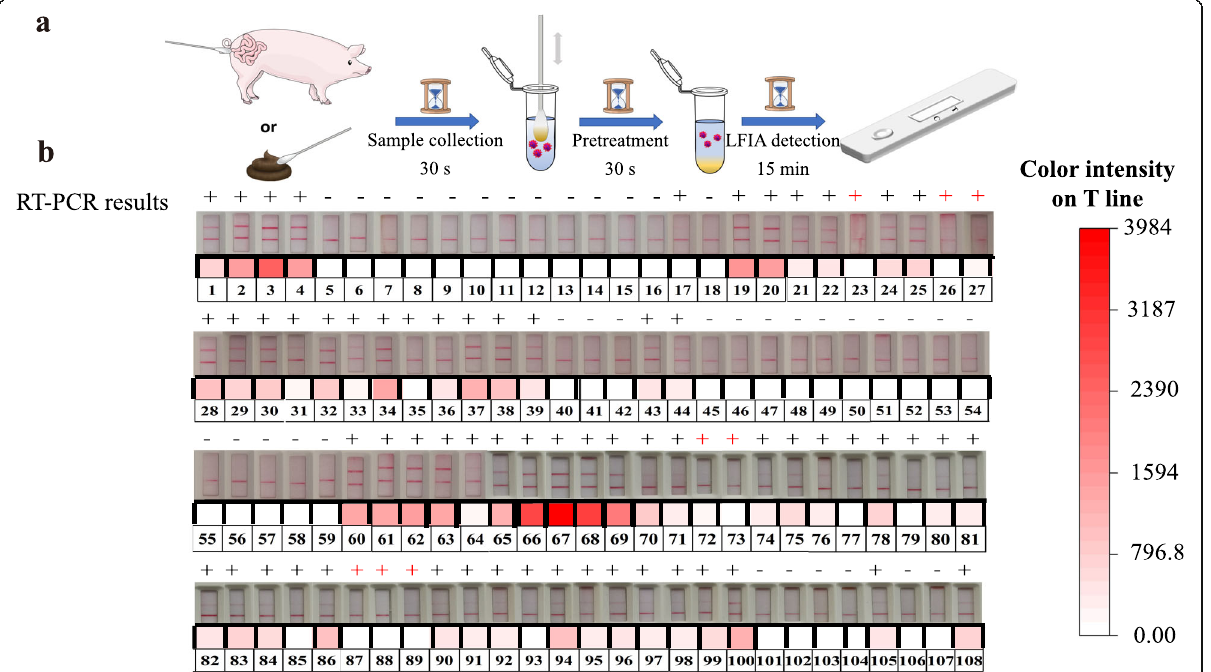
Fig. 7 Detection of PEDV in clinical swine fecal samples. a Workflow and turnaround time for clinical PEDV detection with LBs-LFIA. b Swine fecal sample detection results. Each sample was confirmed by RT-PCR in advance